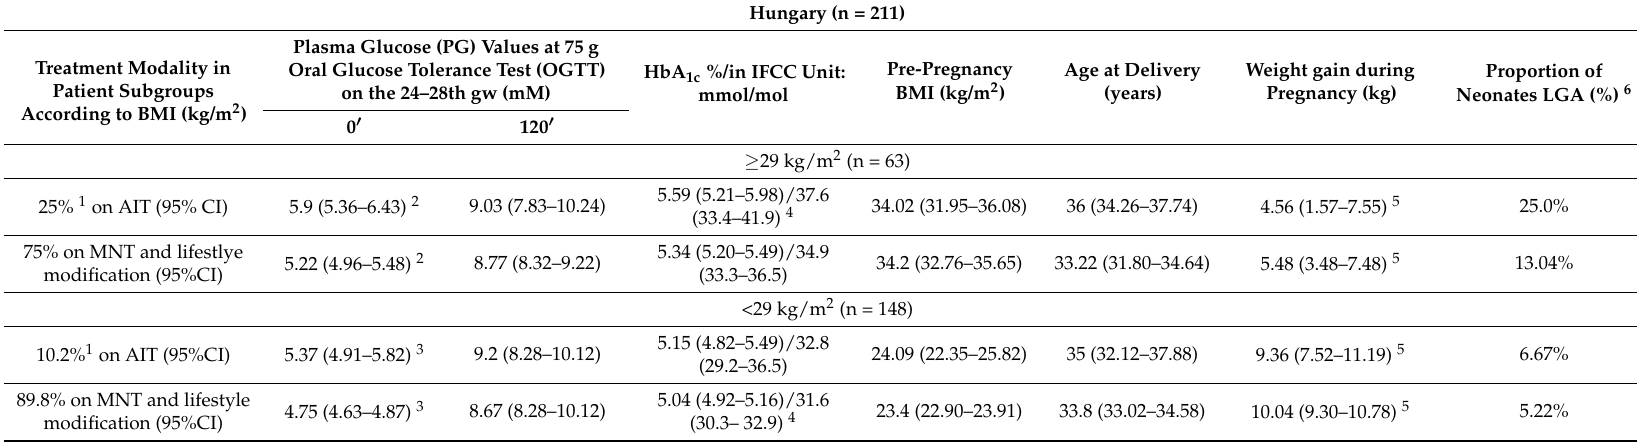
Table 1. Clinical characteristics and rates of antenatal insulin therapy (AIT) use in pregnant women with gestational diabetes mellitus (GDM) according to pre-pregnancy body mass index (BMI) defined